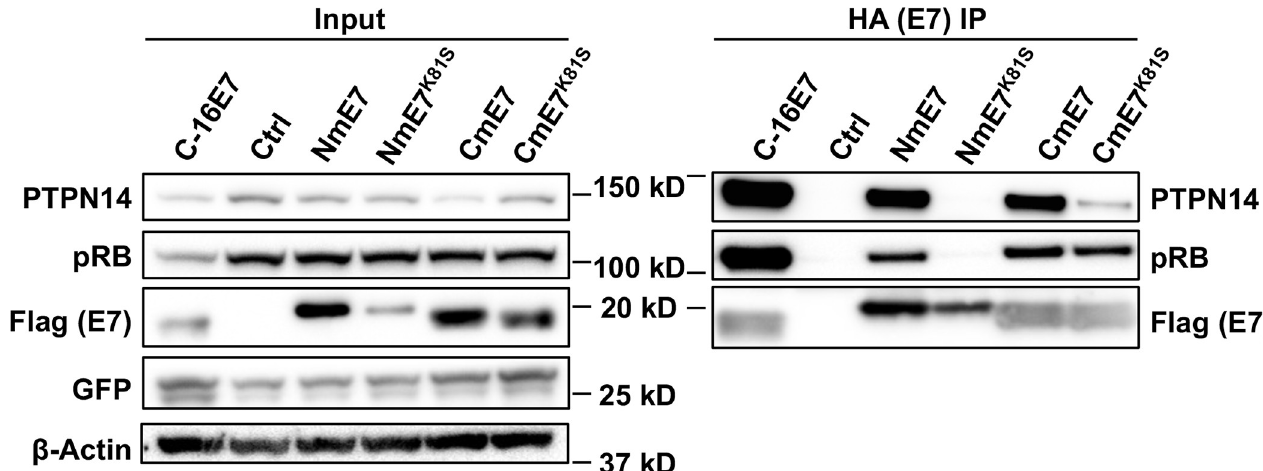
Fig 2. A lysine at amino acid position 81 in MmuPV1 E7 is critical for the interaction with PTPN14. NIH 3T3 cells were transfected with either empty vector (N) or plasmid constructs that express N-terminally and C-terminally HA/FLAG epitope-tagged HPV16 E7, WT MmuPV1 E7, or MmuPV1 E7 K81S mutant. MmuPV1 E7 constructs were either N- or C-terminally tagged as indicated. Cells were harvested and subjected to immunoprecipitation with HA antibodies. For HA IP, 1 mg of HPV16 E7 and 3 mg of other lysates was used and 100 ug WCL on 4–12% mini gels was used for input Western blot analysis. Whole cell lysates (Input) and HA IP eluates were subjected to western blot analysis using antibodies against PTPN14, pRb, FLAG (E7), Actin, or GFP (transfection control). Left panel on blot is the same images labeled Experiment 1 in S2 Fig.